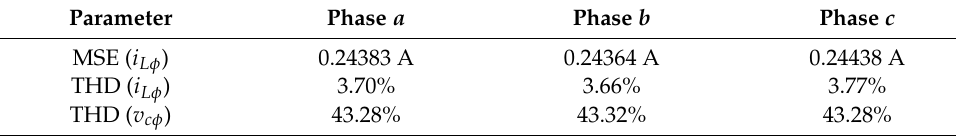
Table 4. Simulation results in the presence of parametric